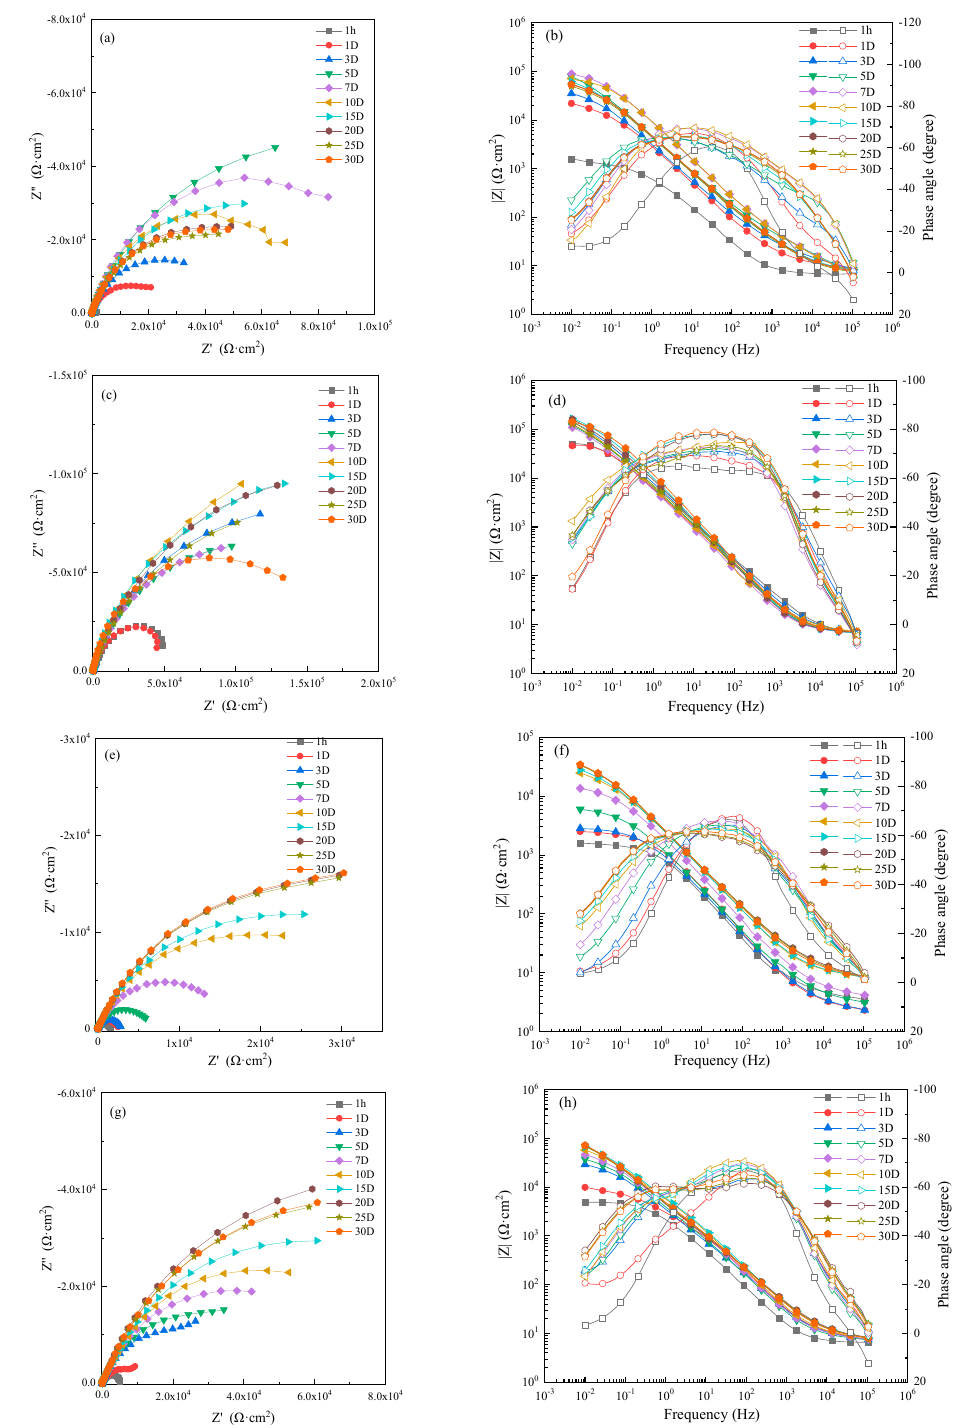
Figure 9. Electrochemical impedance spectra of WZ in seawater: ( a , c , e , g ) Nyquist diagrams and ( b , d , f , h ) Bode diagrams in static, 1 m/s, 3 m/s, 5 m/s seawater .